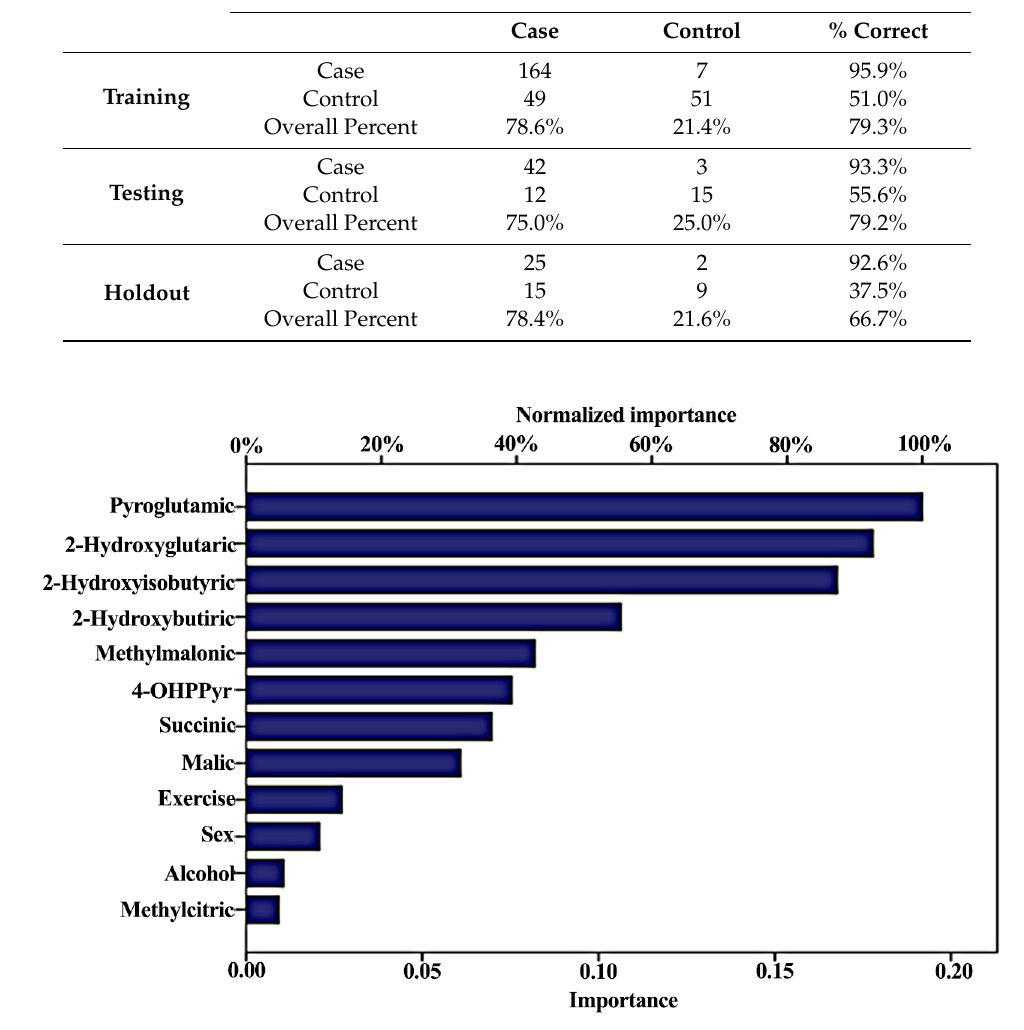
Figure 6. Contribution of Organic Acids and demographic characteristics to the predicted accuracy of the Artificial Neuronal Networks